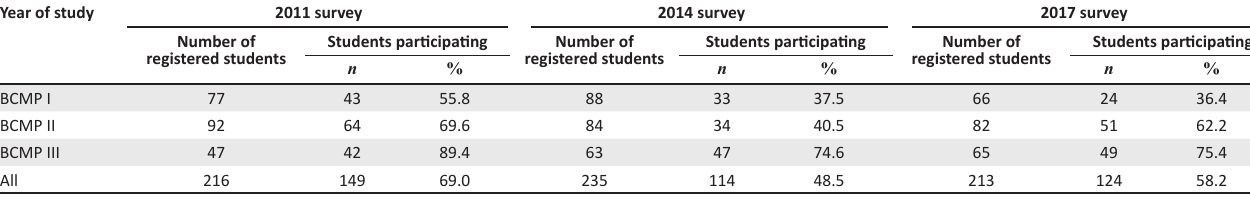
TABLE 1: Participation in the 2011, 2014 and 2017